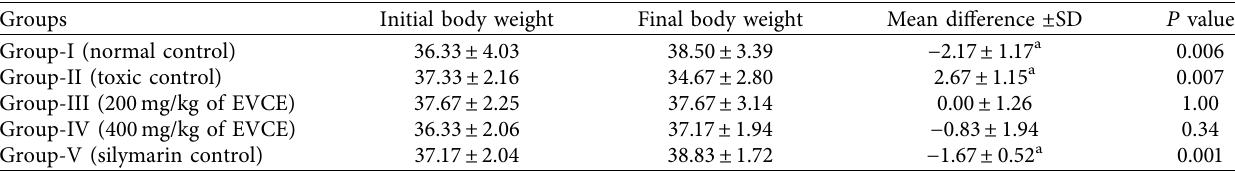
Table 3: Mean weight difference of the initial and final body weight of the mice.